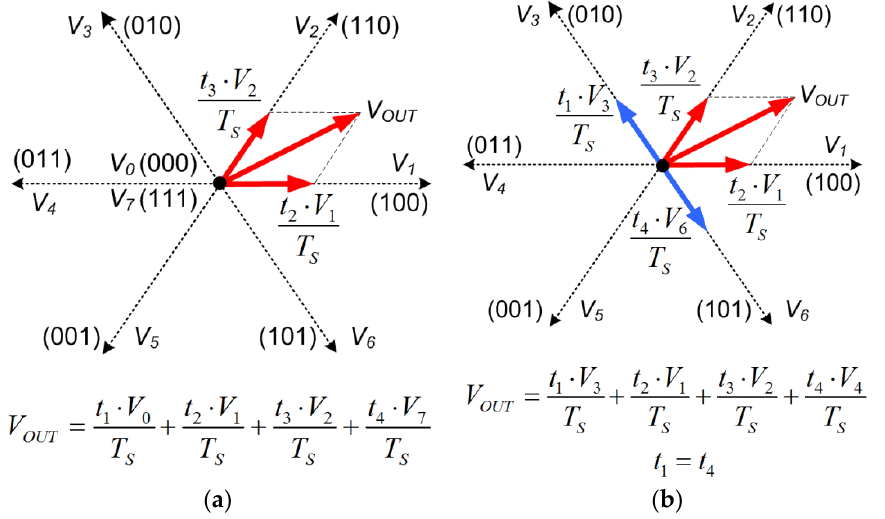
Figure 5. Principle of inverter output voltage forming: ( a ) classic space vector pulse width modulation (SVPWM); ( b ) active zero voltage control modulation.